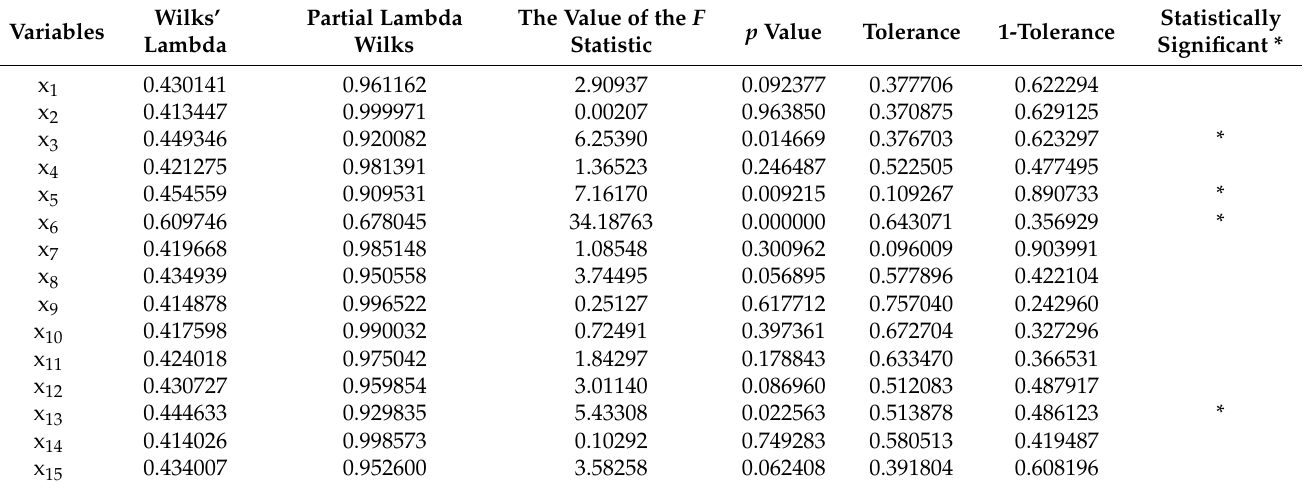
Table 6. Evaluation of the parameters of the discriminant function—15 explanatory variables.